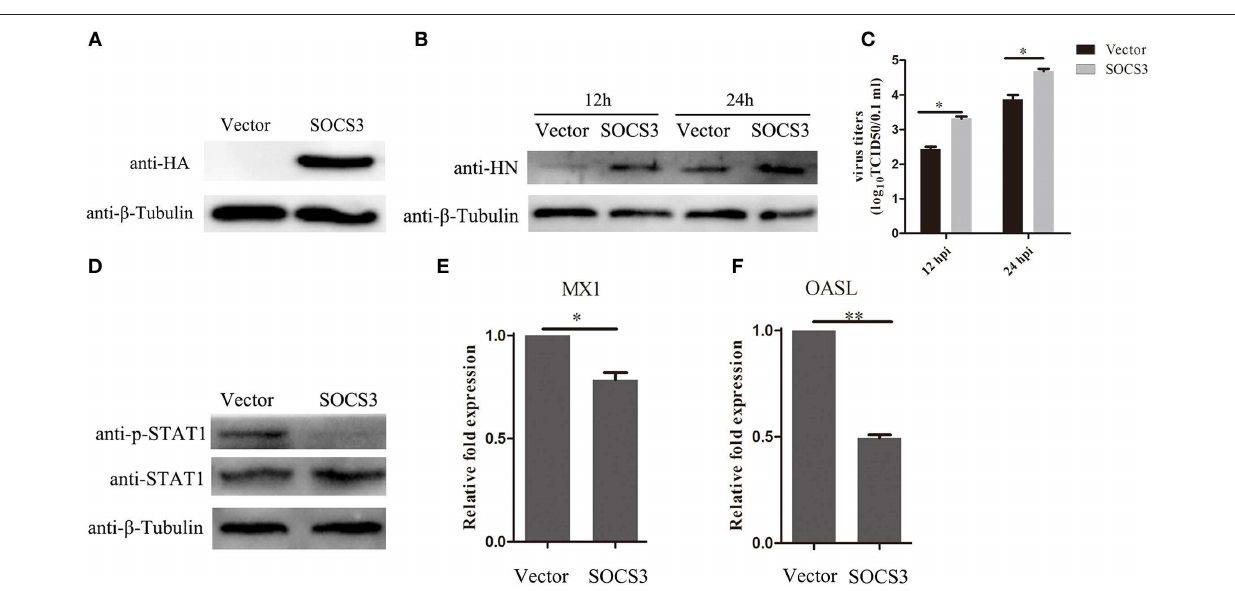
FIGURE 4 | Overexpression of SOCS3 promotes NDV replication. CEF cells were transfected with pCMV-SOCS3-HA and pCMV-HA. At 24h post transfection, CEF cells were infected NDV (0.1 MOI), cells and supernatant were harvested at 12 and 24 hpi. (A,B) WB was performed to detect the expression of exogenous SOCS3 and HN protein of NDV. (C) TCID50 was performed to measure viral RNA replication. (D) WB was performed to detect the expression of STAT1 and phosphorylated STAT1 in SOCS3-overexpressed cells at 24 hpi. (E,F) qRT-PCR was performed to detect the expression of MX1 and OASL. Data presented are from three independent experiments and presented as mean ± SD. * P < 0.5, ** P <